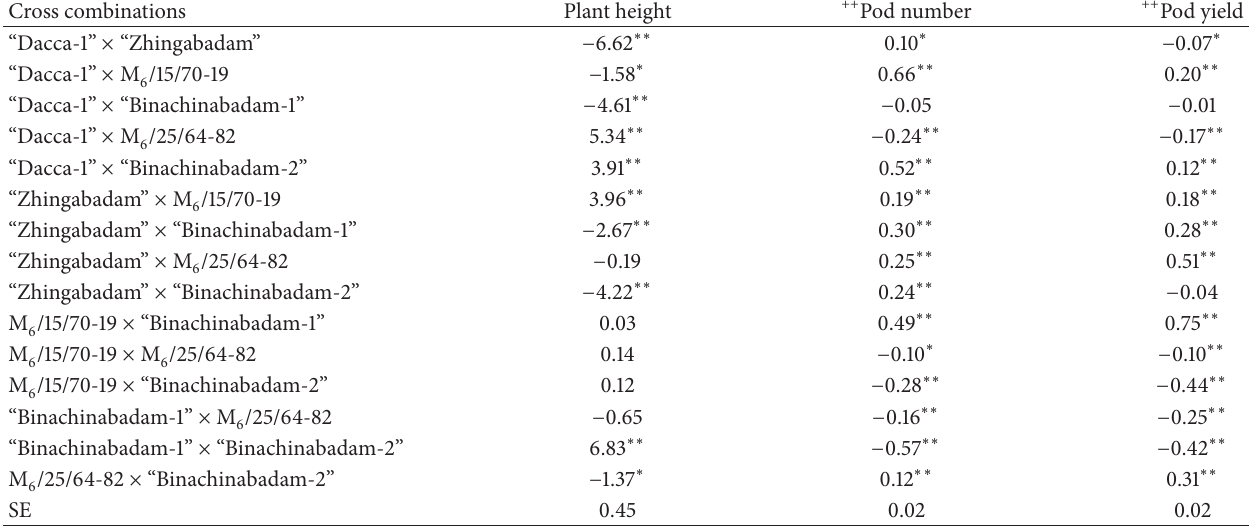
Table 7: Estimates of sca effects in a 6 × 6 F 1 diallel population of pod yield and related traits after salt stress. Cross combinations Plant height ++ Pod